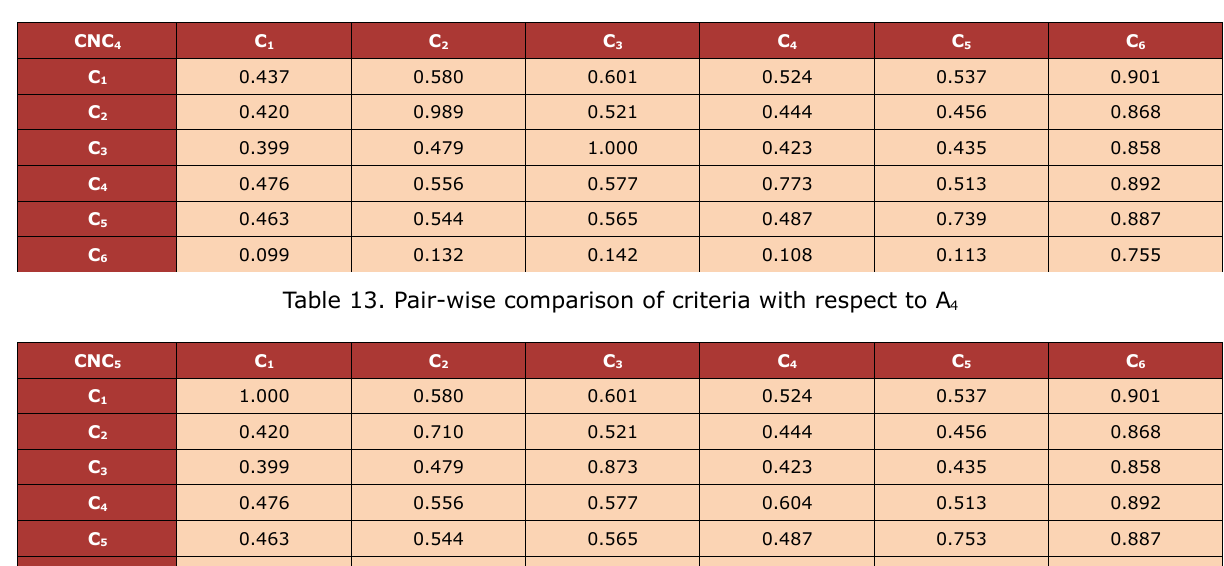
Table 12. Pair-wise comparison of criteria with respect to A 3